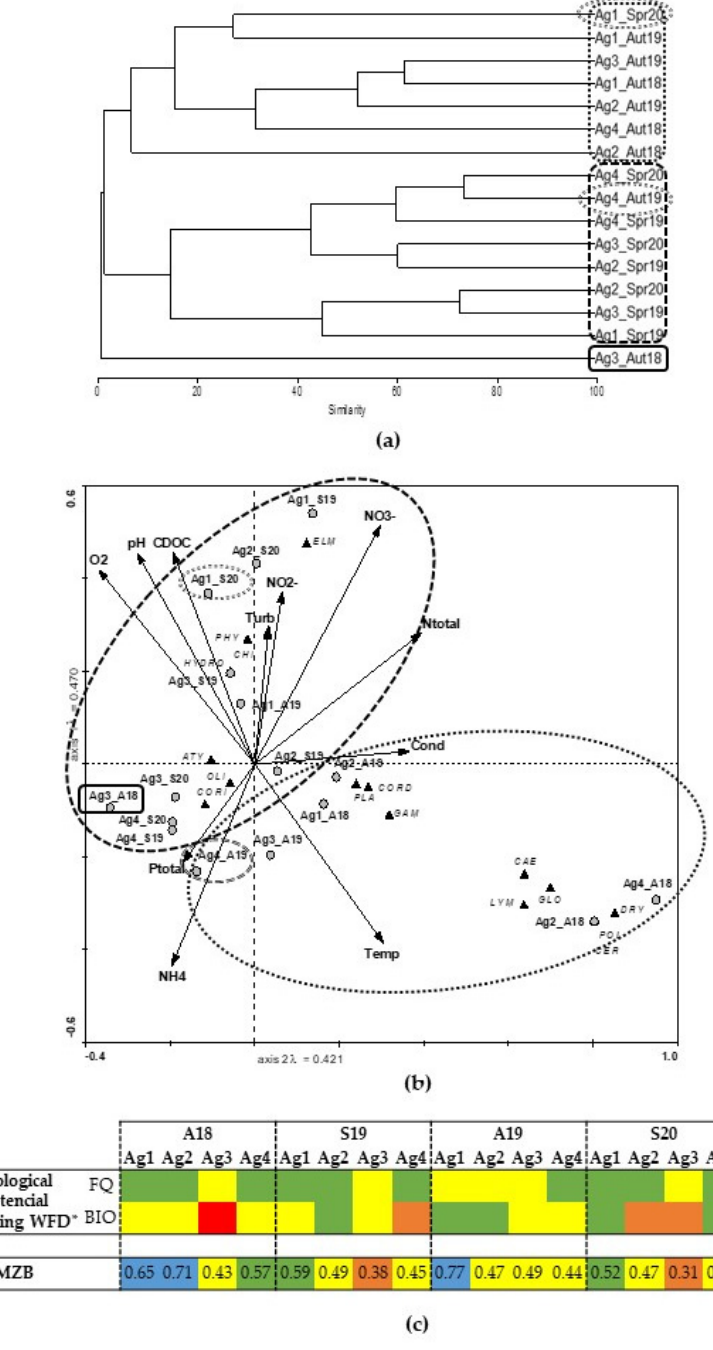
Figure 3. ( a ) Aguieira complete linkage dendrogram of benthic macroinvertebrates similarity; ( b ) Canonical Correspondence Analysis (CCA); ( c ) ecological potential according to WFD parameters (see Table 1 for more information) and macro-